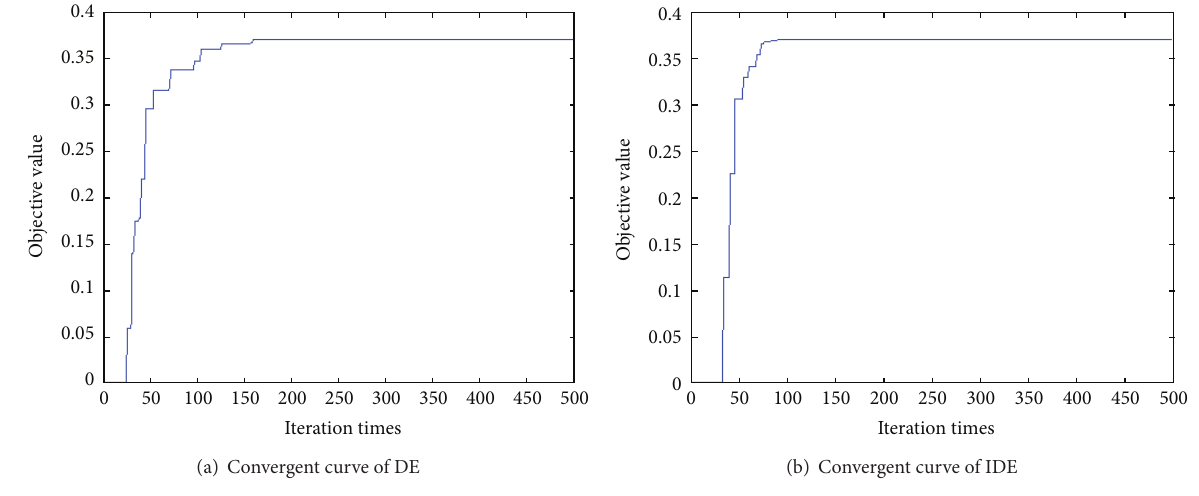
Figure 5: Convergent curve of DE and IDE. Table 2: The results for Experiment 1.